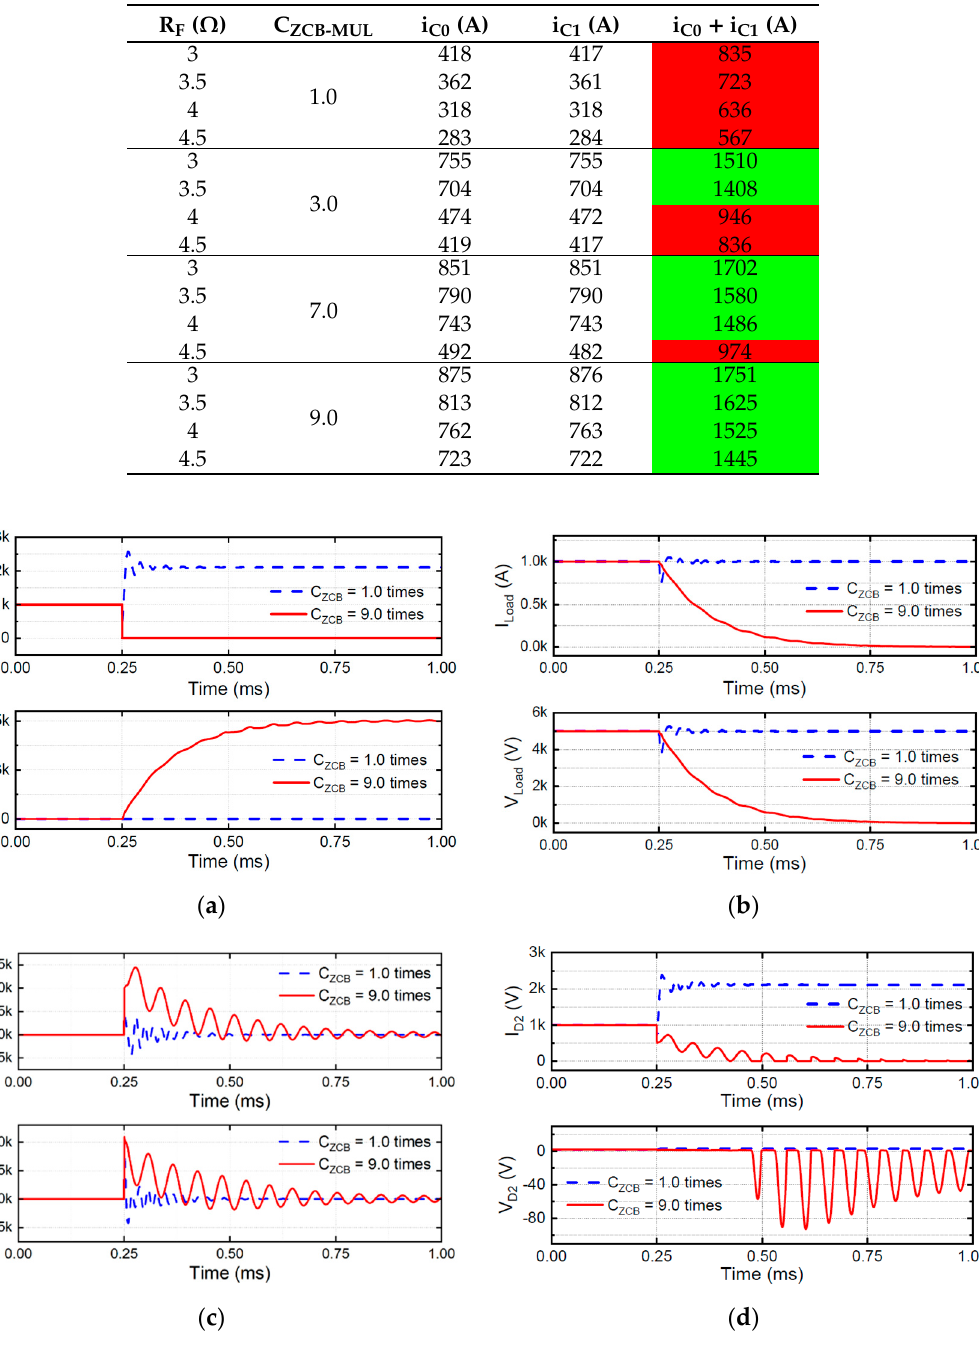
Table 5. Transient current and fault resistance analysis.